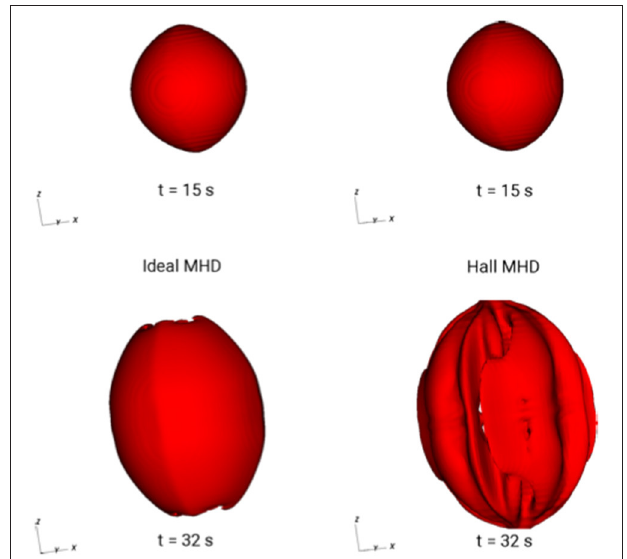
FIGURE 9 | Isodensity contours of the expanding ion cloud viewed perpendicular to the magnetic field at times t = 15 and 32s for the ideal and Hall MHD